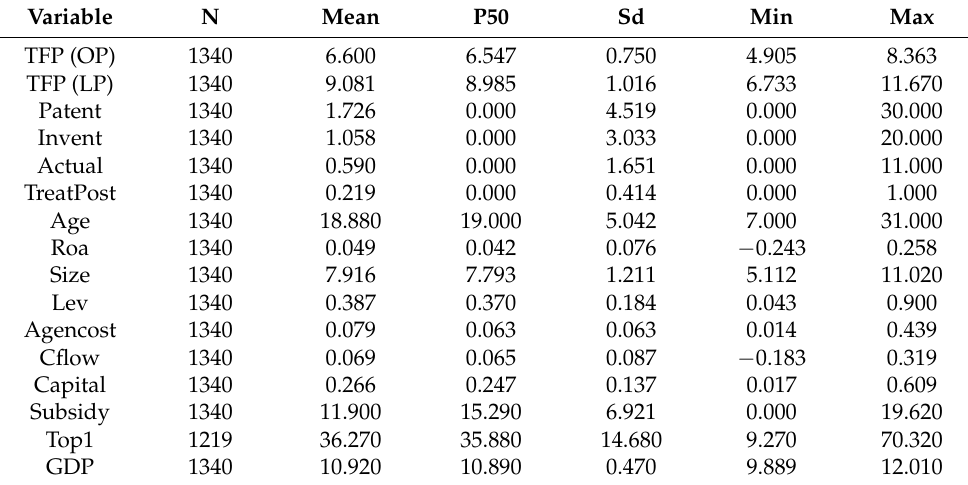
Table 2. Descriptive statistics of the main variables.